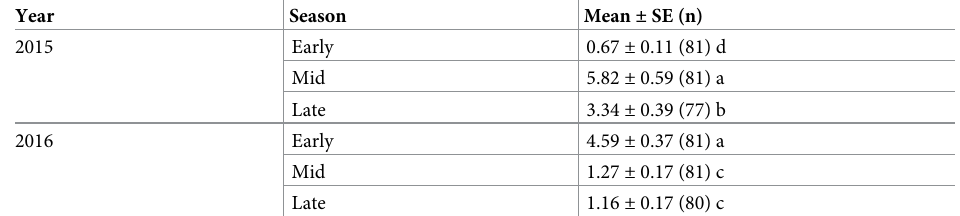
Table 3. Density of insect natural enemies per cm 2 area of sticky card early, mid, and late season in 2015 and 2016.